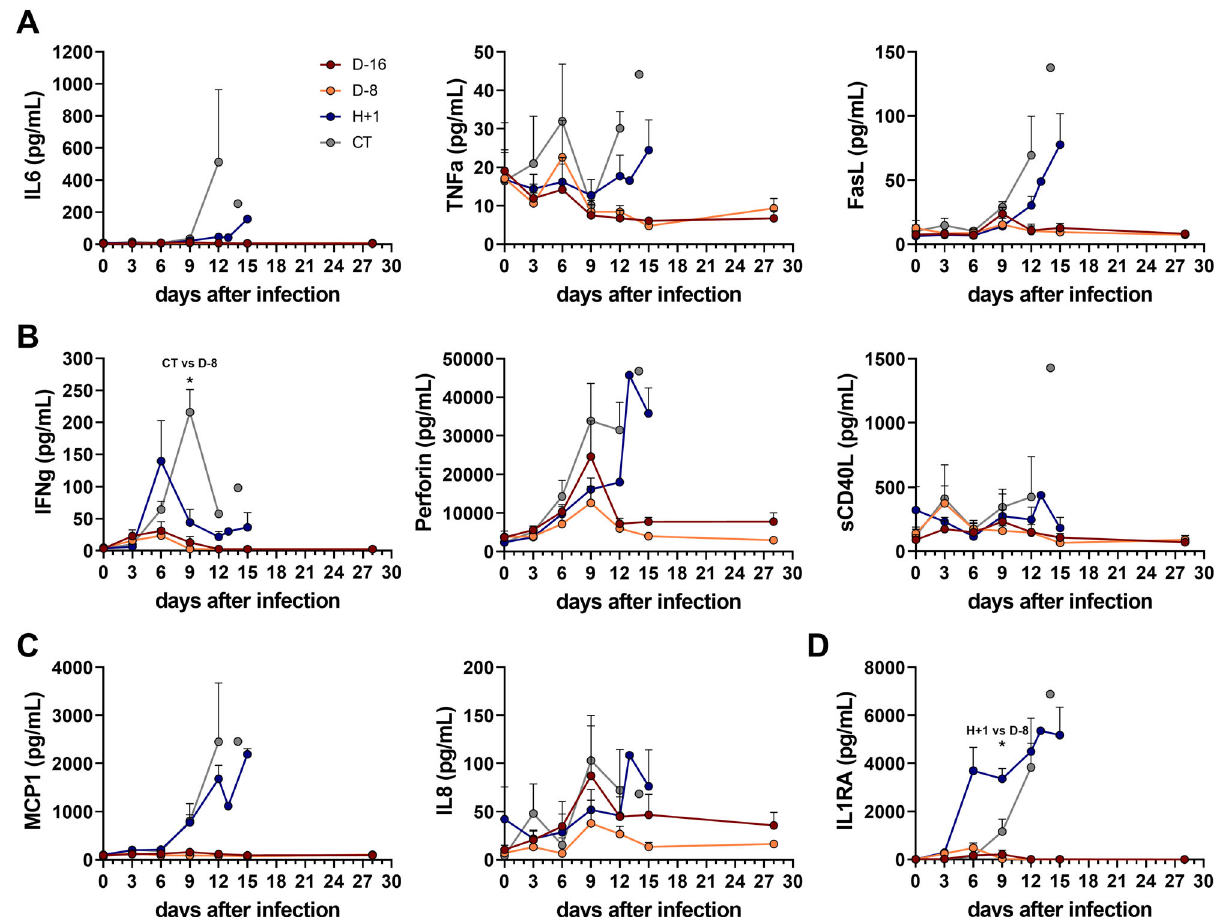
Fig. 2 | Release ofsolublemediators into the plasma ofinfected monkeys after LASV challenge. Plasma concentrations of A the pro-in fl ammatory cytokines IL6, TNF α , and FasL, B the T-cell response-related mediators IFN γ (CT vs D-8 p =0.0327), perforin, and sCD40L, C the chemokines MCP1 and IL8, and D anti- in fl ammatory IL1RA (H+1 vs D-8 p =0.0327). All plasma concentrations were